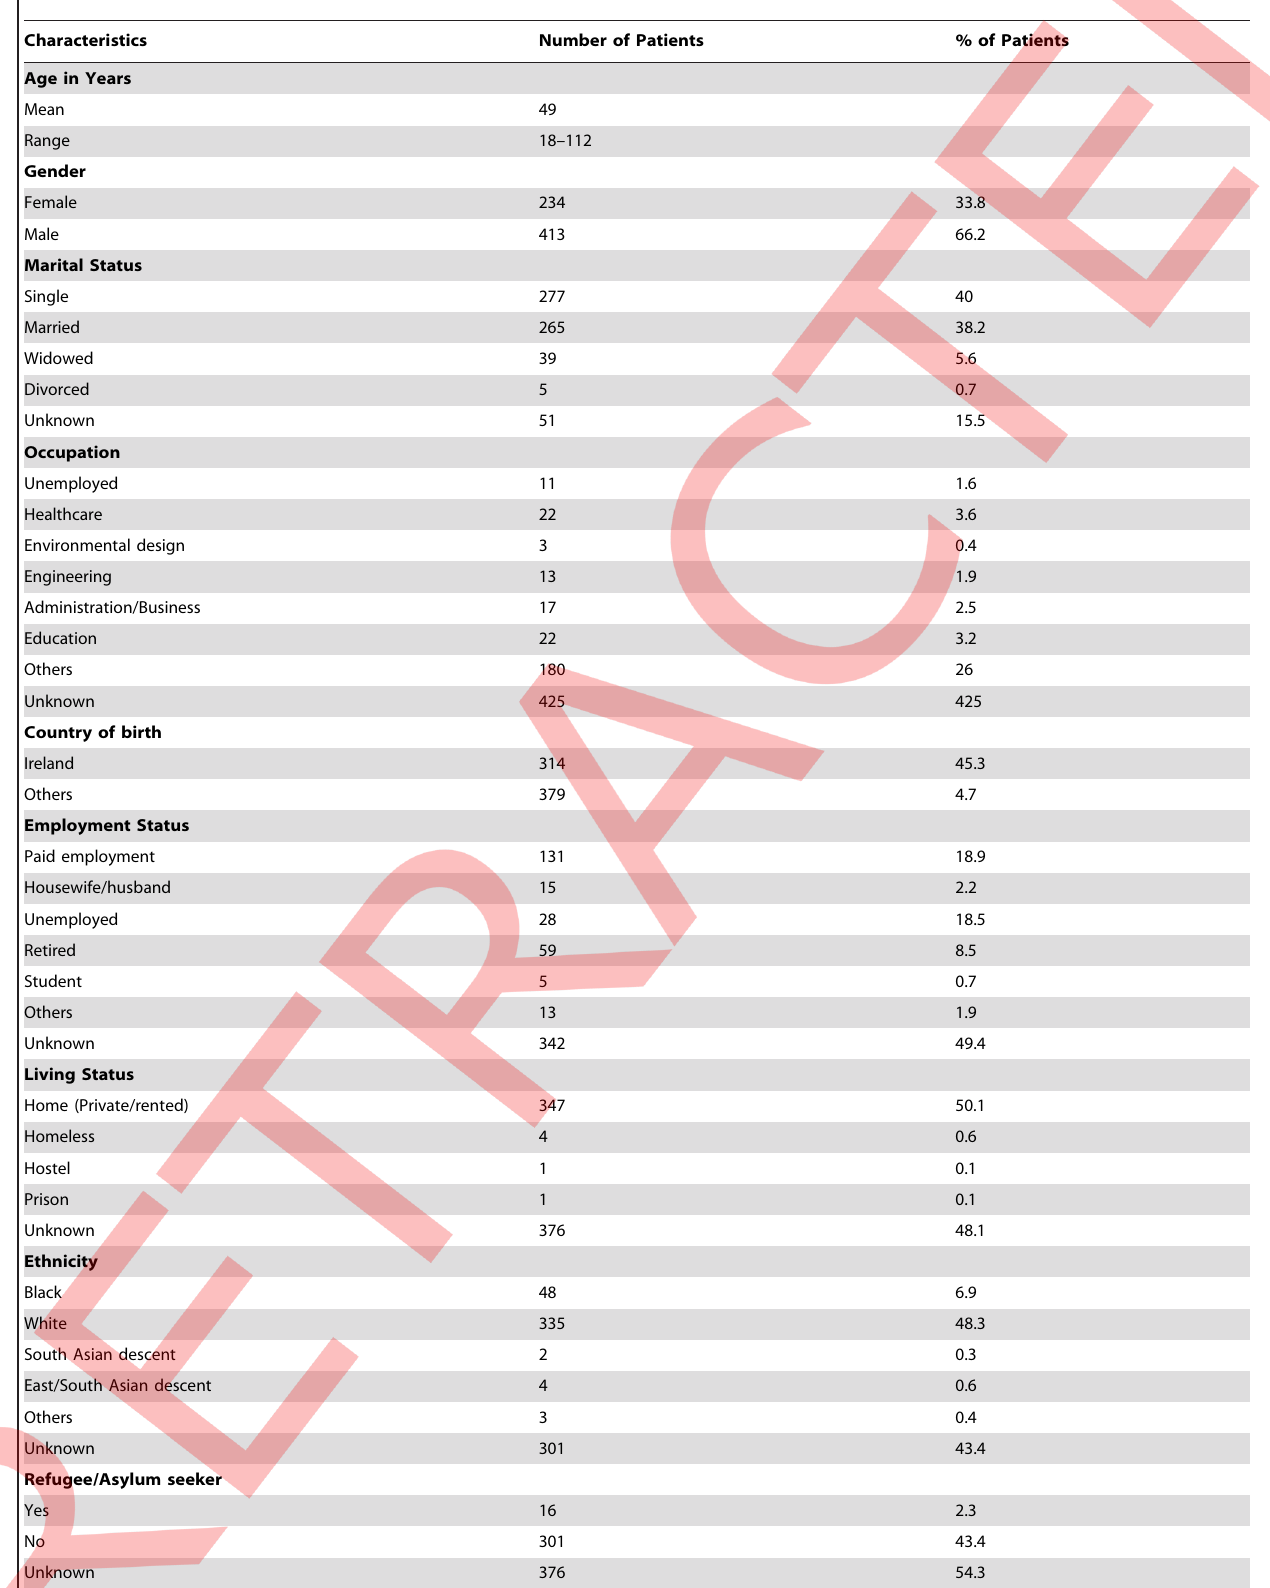
Table 1. Study Participants